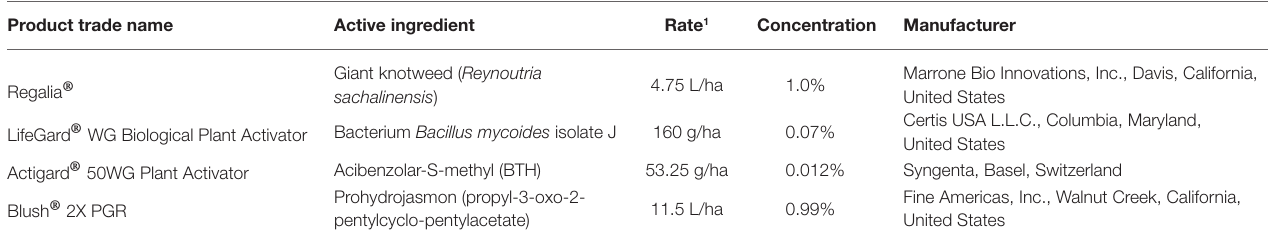
TABLE 1 | List of product trade names, active ingredients, rates/concentrations, and manufacturers of the elicitors of plant defenses used in this study. Product trade